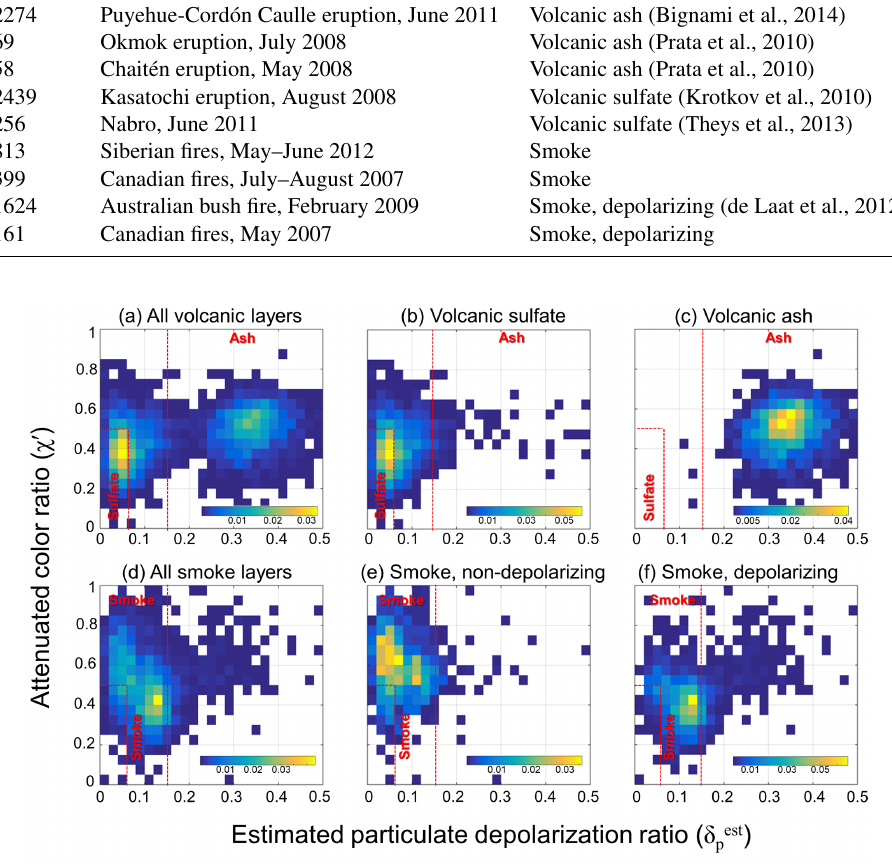
Figure 6. Two-dimensional frequency distributions of attenuated total color ratio and estimated particulate depolarization ratio for layers in Table 1. Distributions are normalized independently by the sum of samples in the subset: (a) all volcanic layers, (b) volcanic sulfate, (c) volcanic ash, (d) all smoke layers, (e) non-depolarizing smoke, and (f) depolarizing smoke. Only layers having integrated attenuated backscatter > 0 . 001sr − 1 contribute. Red dashed lines denote the V4 stratospheric aerosol typing